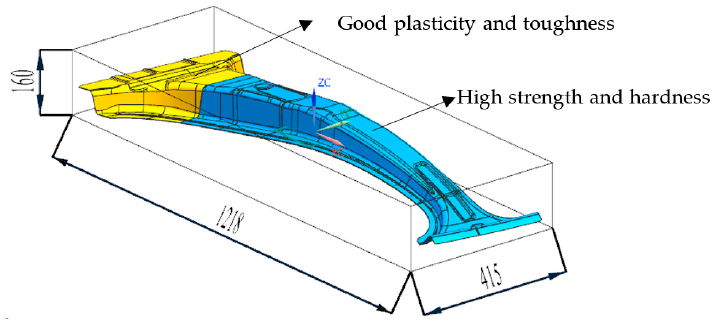
Figure 3. 3D model of the B-pillar.